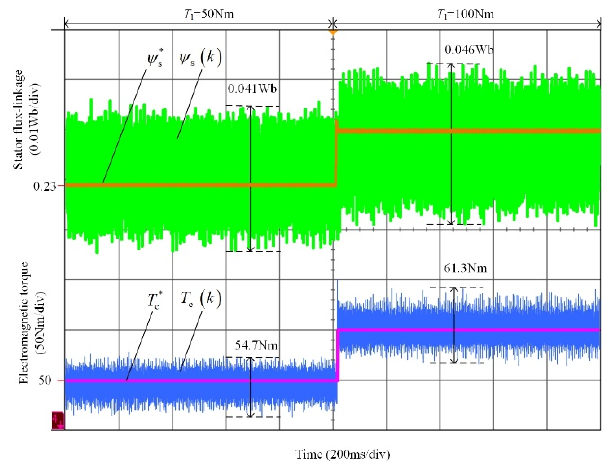
Figure 10. The curves of stator flux-linkage and electromagnetic torque for the conventional MPDTC.